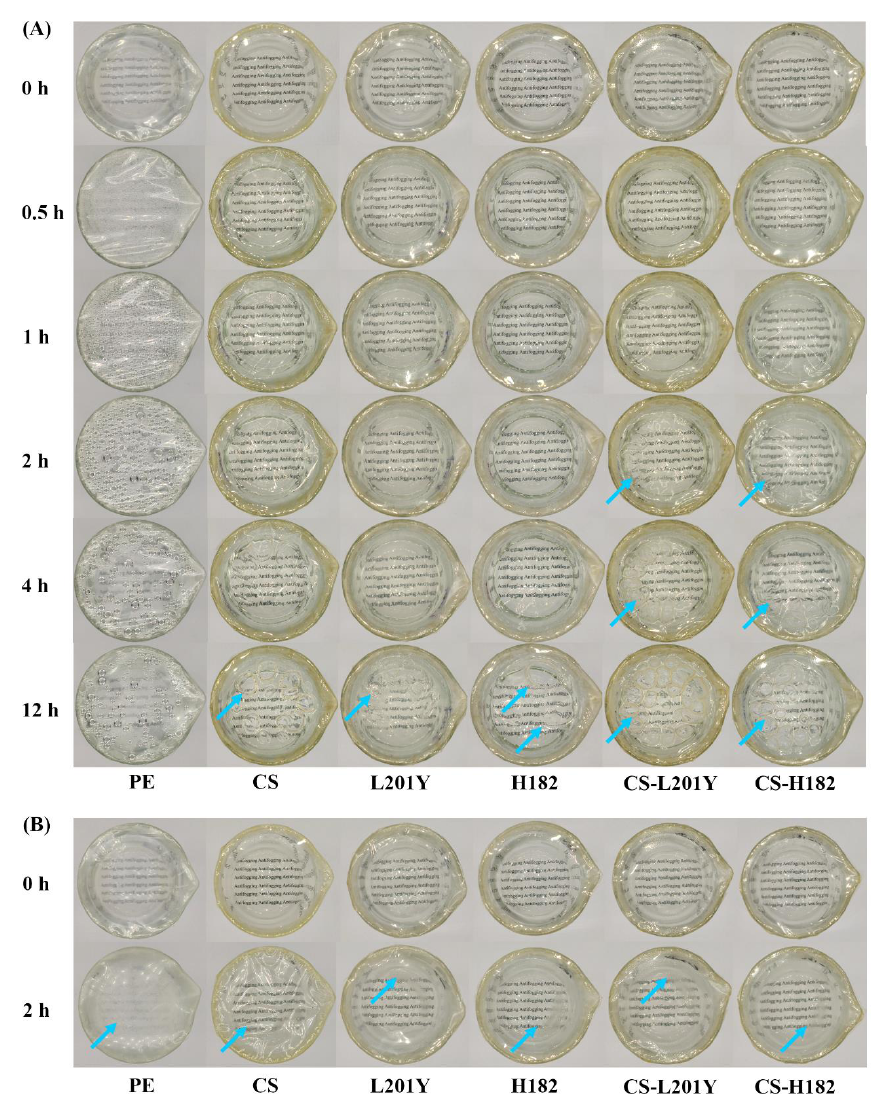
Figure 8. Thermal antifogging property ( A ) and cold antifogging property ( B ) of the monolayer and bilayer films (PE, CS, L201Y, H182, CS-L201Y, CS-H182). The folds and breakage of film were pointed by the blue arrow.